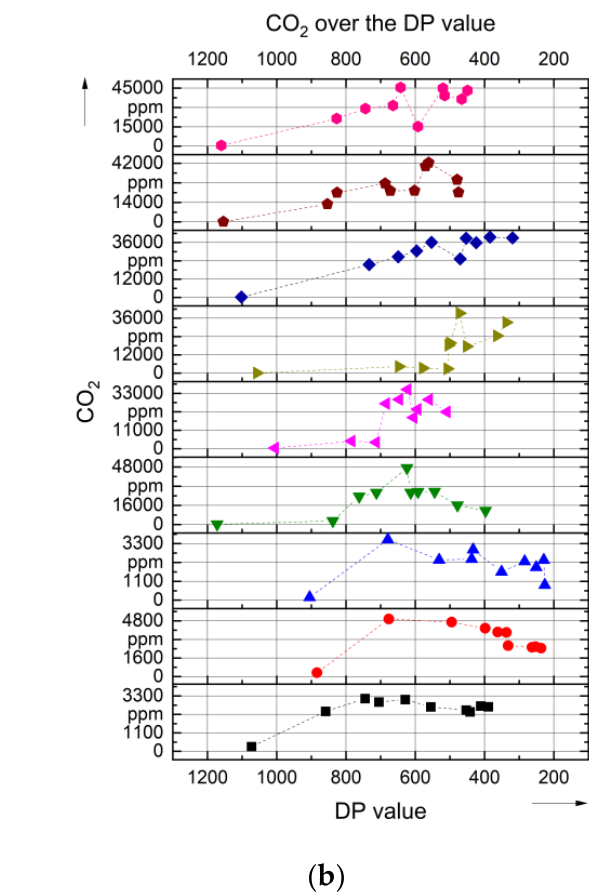
Figure 7. Change of CO concentration for different sealing systems and fluids: ( a ) Change over the aging time; ( b ) Change over the DP value; the legends refer to Figure 6a.